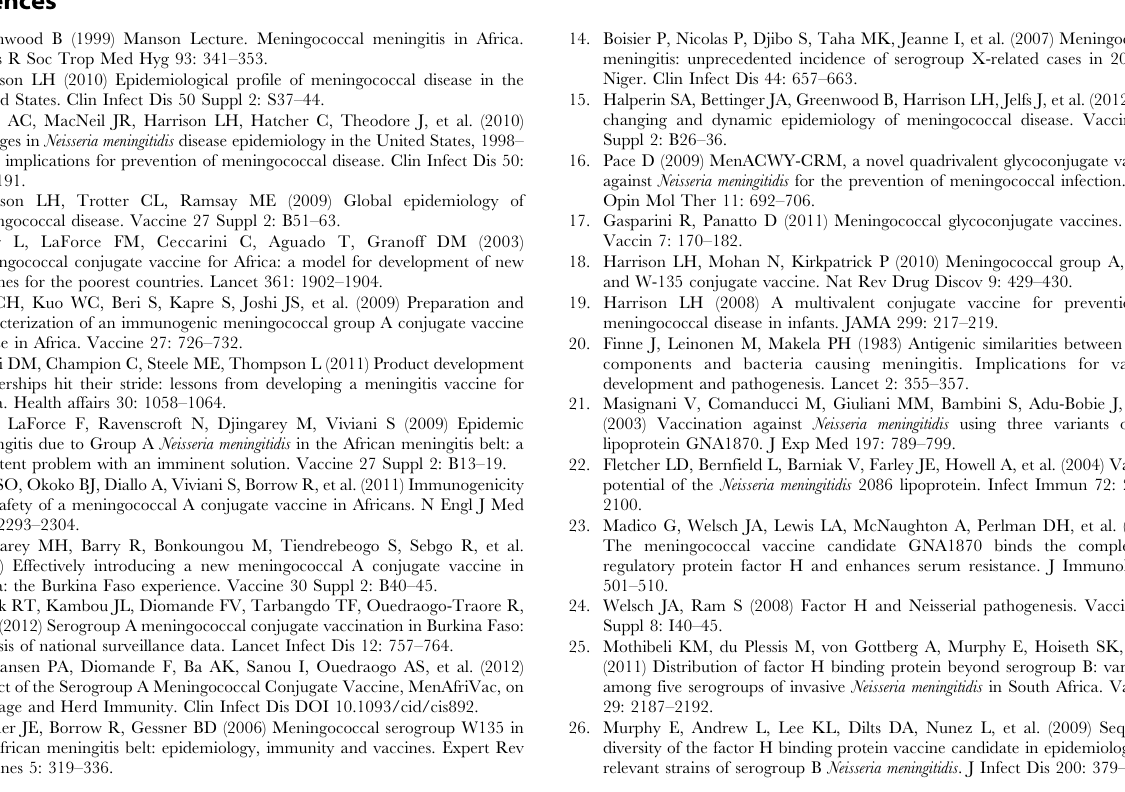
Figure S3 Comparison of serum bactericidal antibody responses of mice immunized with NOMV-fHbp or NOMV-fHbp KO vaccines. Serum bactericidal antibody responses were measured against seven serogroup W isolates with porA VR types related to the PorA contained in both NOMV vaccines. The antibody responses elicited by the NOMV-fHbp KO vaccine are mostly directed at PorA. Bars represent the reciprocal GMT of two or three serum pools. Orange bars, control mice immunized with an NOMV vaccine prepared from the mutant vaccine strain with D lpxl1 and D capsule in which the gene for fHbp had been inactivated; white bars, mice immunized with the NOMV vaccine with D lpxl1 and D capsule and over-expressed fHbp. There were no significant differences in bactericidal responses elicited by two vaccines (respective GMTs of 1053 vs. 1139, P . 0.8 by paired T